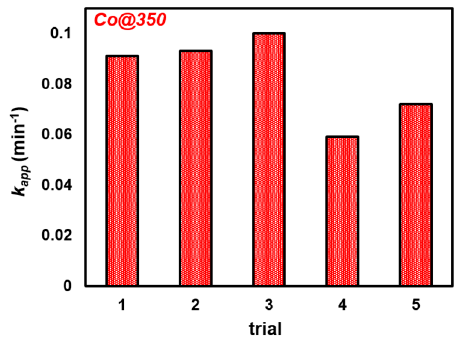
Figure 7. Recyclability of Co@350 for the reduction of 4NP* to 4AP.